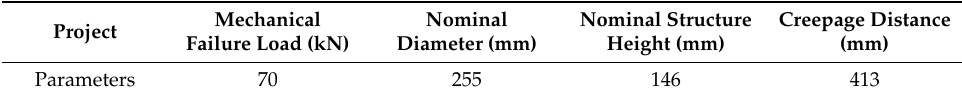
Table 1. Main technical parameters of U70BL insulator.